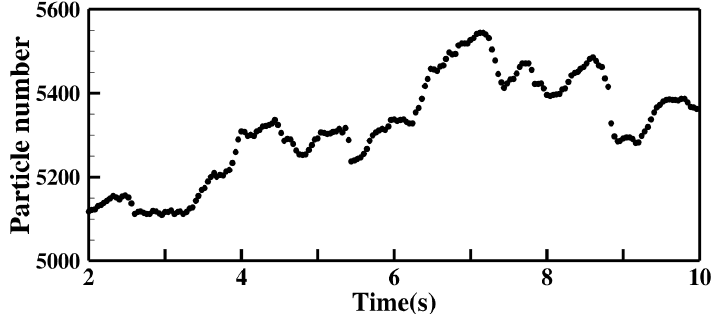
Figure 7. The change of bed height over observation time. ( a ) experimental result given by Van Wachem et al. [18] (reused with permission from Elsevier); ( b ) simulation results. Appl. Sci. 2020 , 10 , x FOR PEER REVIEW